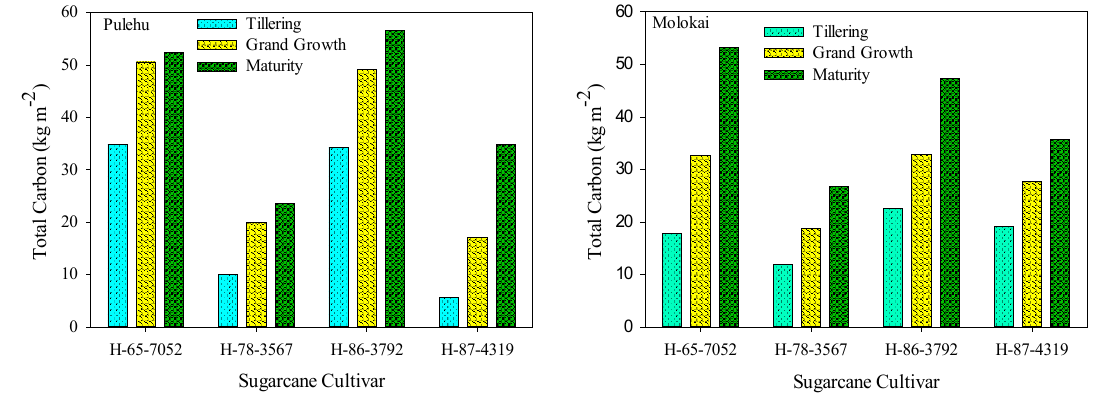
Figure 9. Total Carbon (kg·m −2 ) in the first 120 cm of soil accumulation in the different sugarcane cultivars over the sugarcane growing stages.